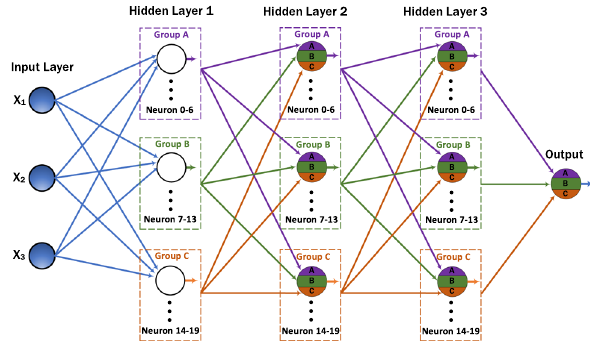
Fig. 11 FPGA data flow of the neural network logic. Output neuron and each neuron in layers 2 and 3 contain three PEs, denoted A, B, and C. Each PE receives and processes data from the corresponding group in the previous layer